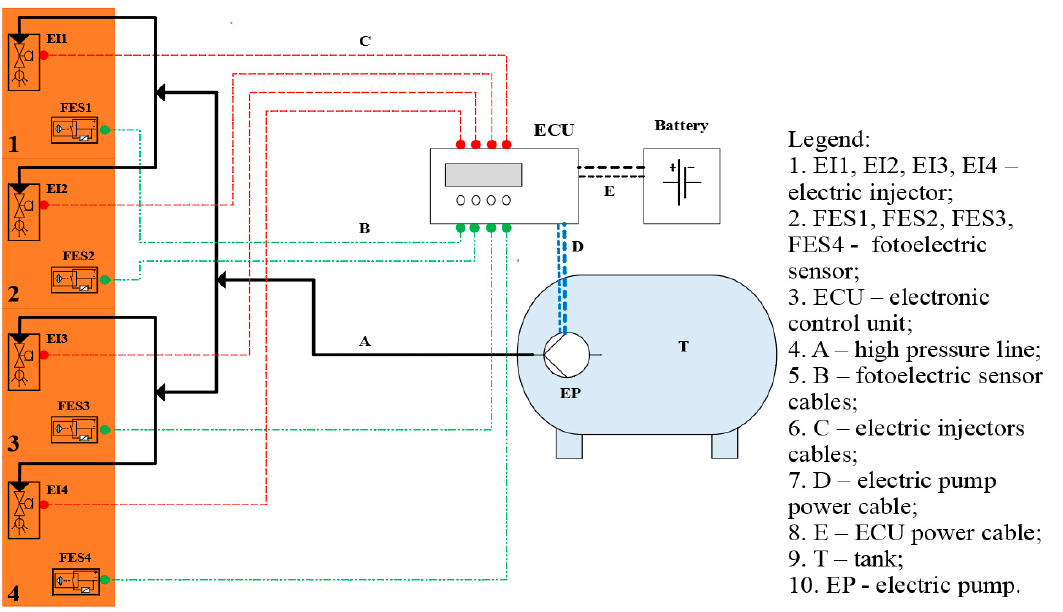
Table 3. Basic parameters of the starter fertilizer application technique.